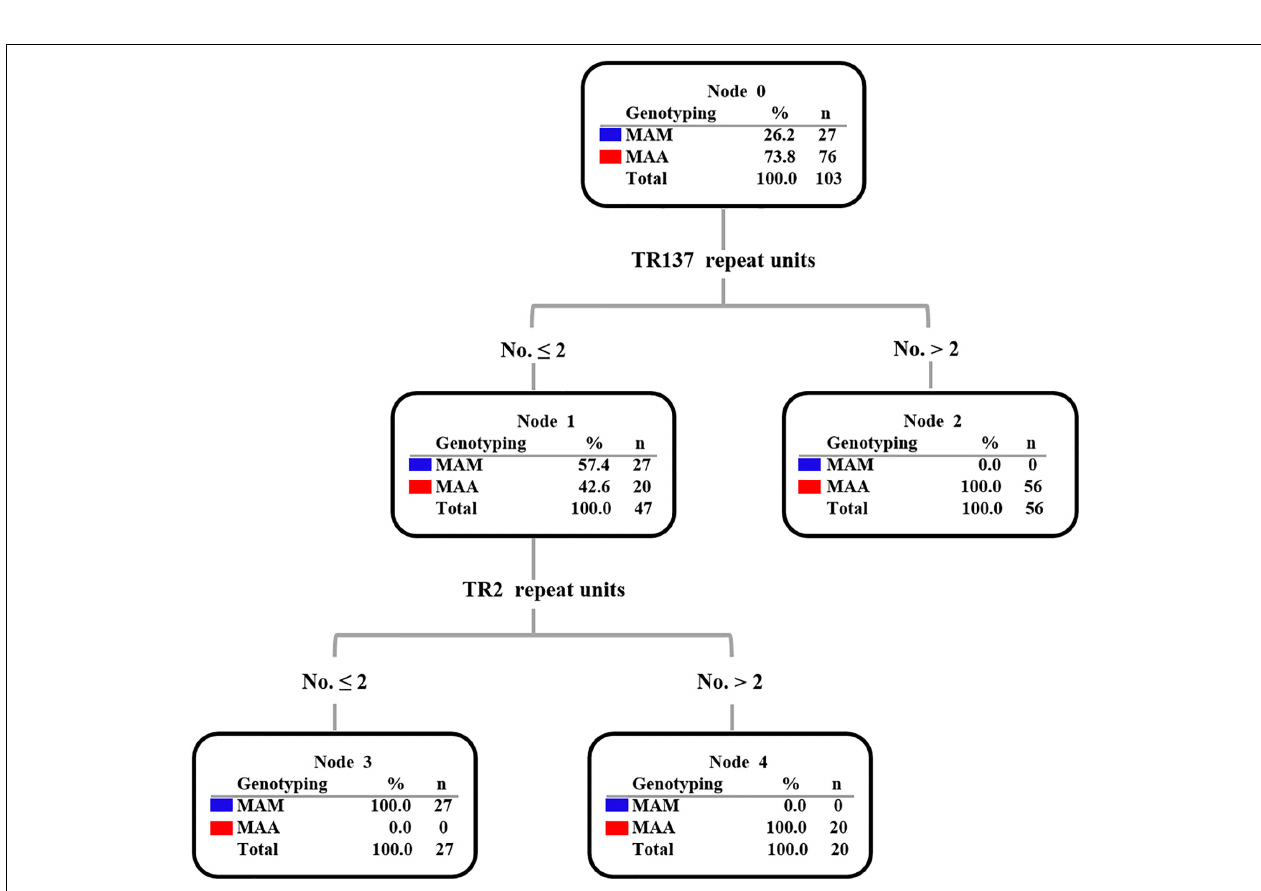
FIGURE 4 | Decision tree diagram based on tandem variable number tandem repeat (VNTR) showing that TR137 combined with the TR2 locus can distinguish Mycobacterium abscessus subsp. abscessus (MAA) and M. abscessus subsp. massiliense (MAM) in the Mycobacterium abscessus complex (MABC).